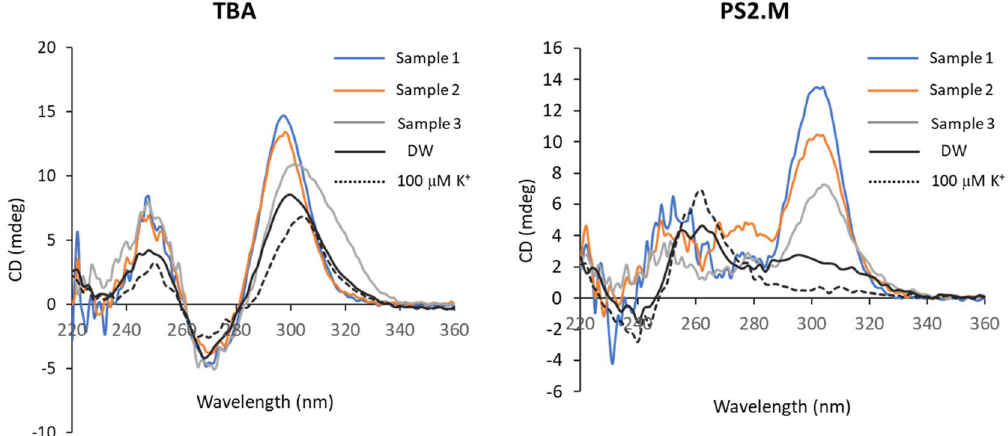
Figure 9. CD spectra of TBA and PS2.M added by three effluent samples (Sample 1–3), DW and 100 μM K +